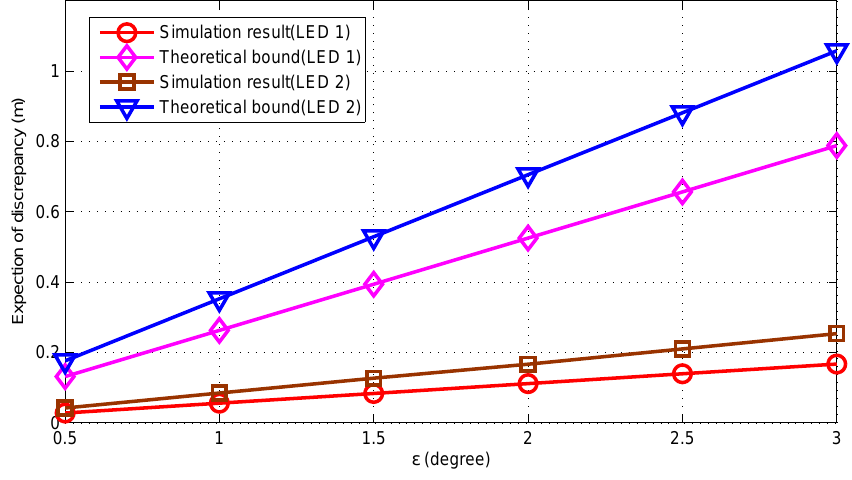
Figure 7. Performance analysis versus ith LED selection.